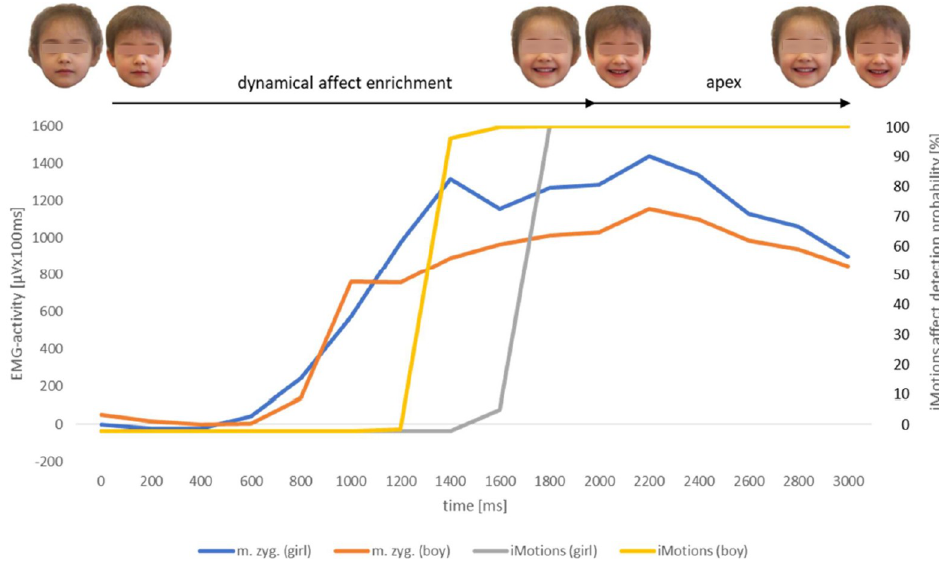
Fig 8. EMG-activity (N = 43) of m. zygomaticus [ μ Vx100ms] of healthy observers in response to the presented videoclips displaying the facial expression of happiness naturalistic evolving from a neutral face of the girl’s respective boy’s reference portrait; software based (AFFDEX/iMotions) affect detection probability values [%] of the same presented stimuli; measurement interval for both procedures 3000ms. m.zyg. (girl) = EMG-activity of musculus zygomaticus in response to the girl’s face video. m.zyg. (boy) = EMG-activity of musculus zygomaticus in response to the boy’s face video. iMotions (girl) = software based affect detection probability [%] in response to the girl’s face video. iMotions (boy) = software based affect detection probability [%] in response to the boy’s face video. The yellow (boy) and grey (girl) lines are superposed in part within this graph because of a partly similar time course.